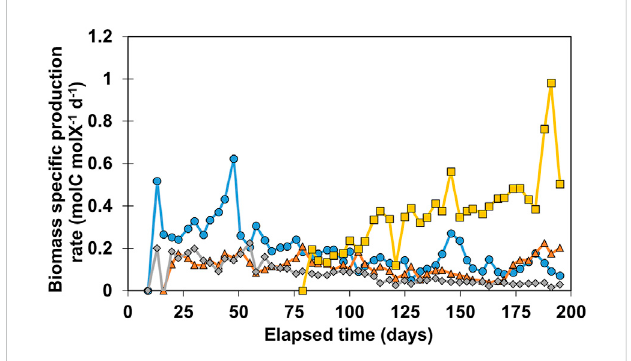
FIGURE 2 Calculated q p values for all reactors. R1 is in blue circles, R2 in orange triangles, R3 in grey diamonds, and R4 in yellow